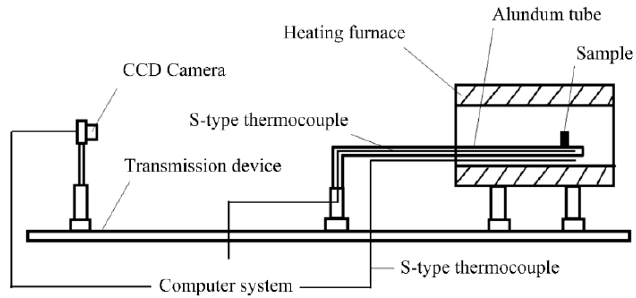
Figure 1. The schematic diagram of the experimental apparatus for measuring melting temperature.